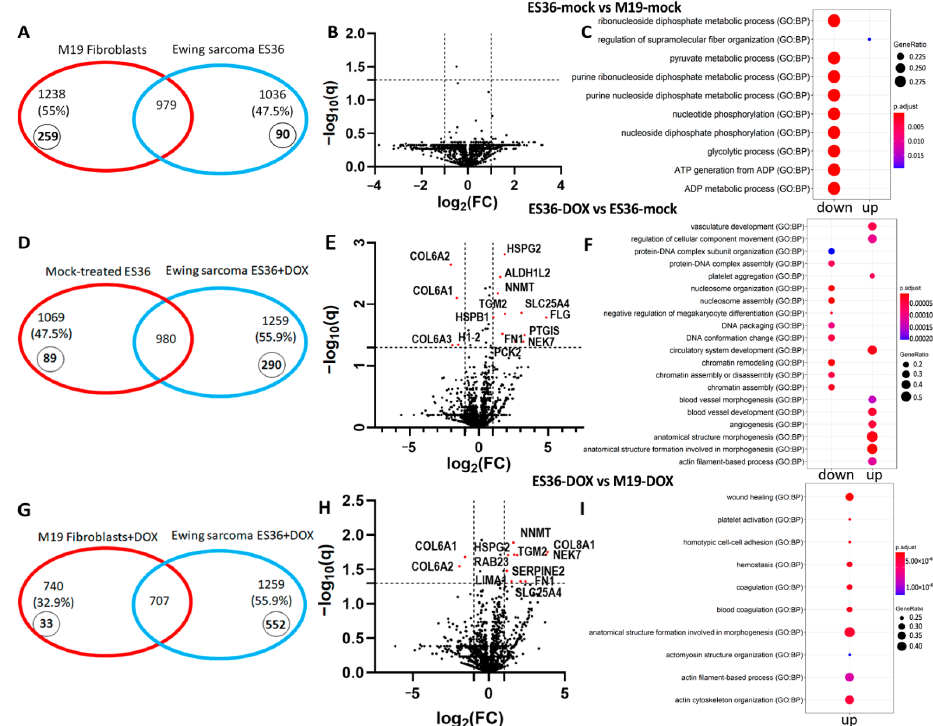
Figure 4. Human fibroblasts and ES cells ES36 display distinct protein compositions. ( A , D , G ) Venn diagram showing common and unique proteins in mock- or doxorubicin (DOX)-treated M19 and patient-derived ES36 cells. Overlapped proteins were identified in three replicates per each sample. Unique proteins for each type of cell and/or treatment are marked in bold and italics inside small circles. Created using Microsoft Office 2010. ( B , E , H ) Differential protein expressions between M19 and ES36 samples. Volcano plots of protein abundance between samples showing the distribution of proteins identified in ES36 and M19 during mock or doxorubicin treatment. Data presented as Log2 fold ratio between samples. The most significant genes are highlighted in red and we used an absolute threshold q(FDR) ≤ 0.05 and |log2(FC)| ≥ 1 ( C , F , I ) Gene ontology (GO) enrichment analysis for 60 potential targets (30 upregulated and 30 downregulated) of ES36 vs. M19, ES36-DOX vs. ES36-mock treated, and ES36-DOX vs.M19-DOX samples with p < 0.05 and most value of |log2(FC)| for more complete enrichment. The dot-plot of top-upregulated and downregulated biological functions was performed using p adjusted < 0.05. Hierarchical clustering of the protein molecular signature of ES36 and M19 was generated by the computational tool R gProfiler2. Supplemental Tables S1–S3 provide details of all molecular